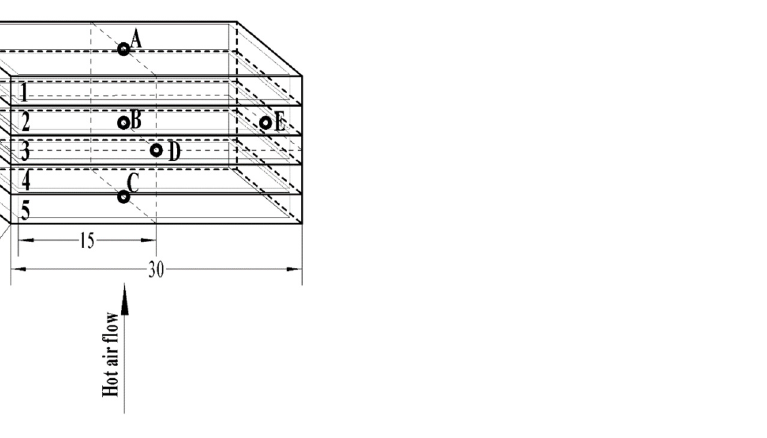
Figure 3. Five-layer (1–5) container for sample temperature measurements with five positions (A–E) and pre-drilled holes (all dimensions are in cm) (Adapted from Li et al. [32]).